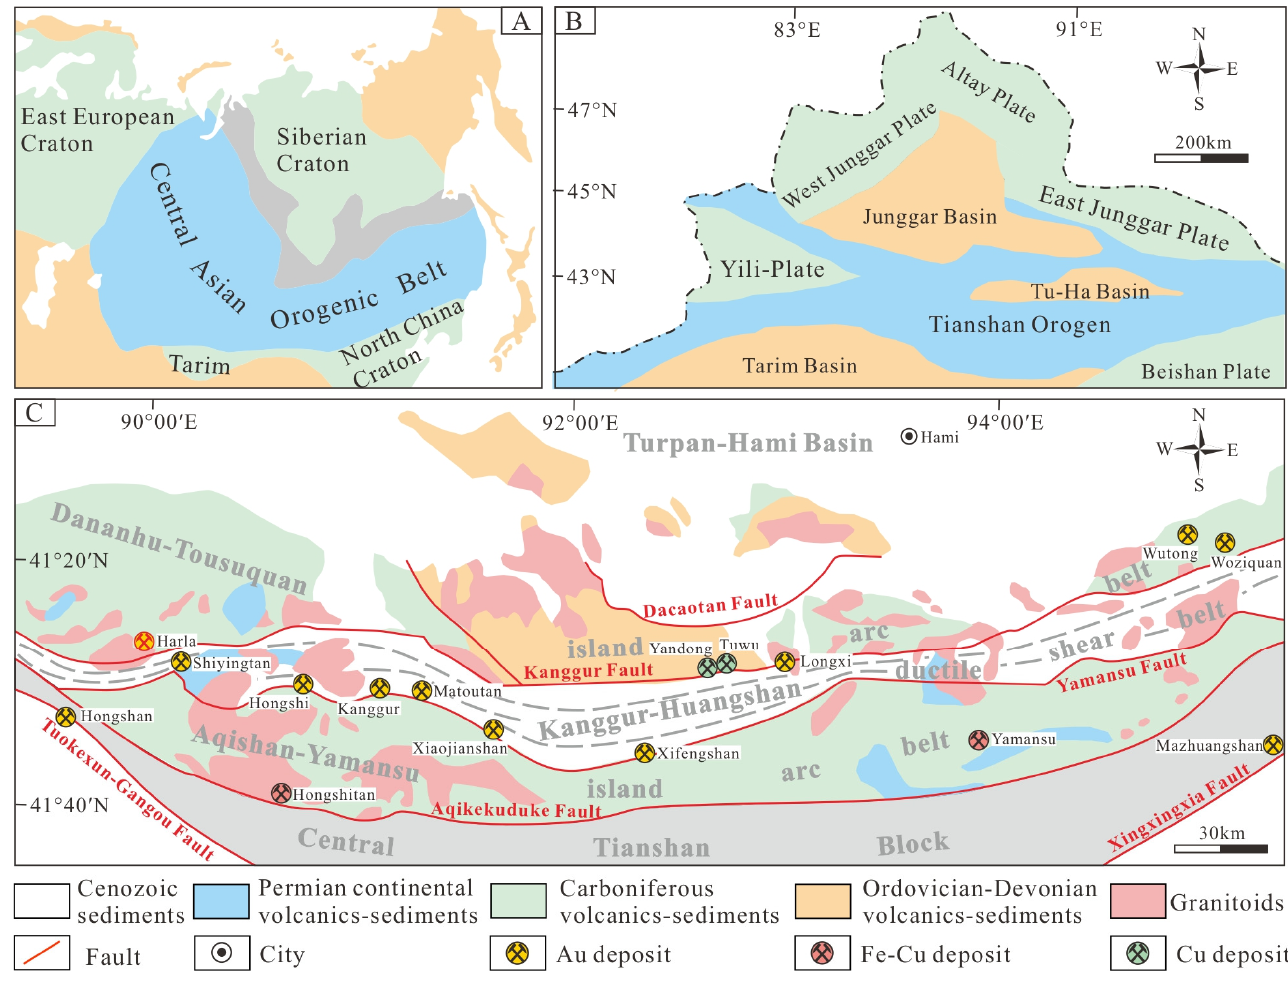
Figure 1. ( A ) Tectonic framework of the Central Asian Orogenic Belt (modified according to Jahn et al.) [1]; ( B ) sketch map showing geological units of the Tianshan Orogen (modified according to Chen et al.) [2]; ( C ) geological map of the ETO (modified according to Wang et al.) [3]. The Harla gold deposit, located in the western Kanggur-Huangshan ductile shear belt of the ETO, was discovered by the Geological Party No. 11 of the Xinjiang Bureau